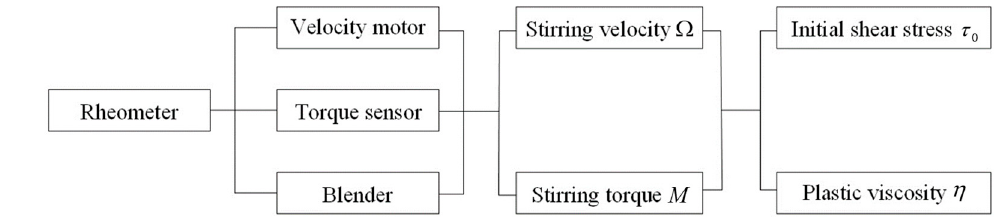
Figure 3. Rheological parameter testing process.